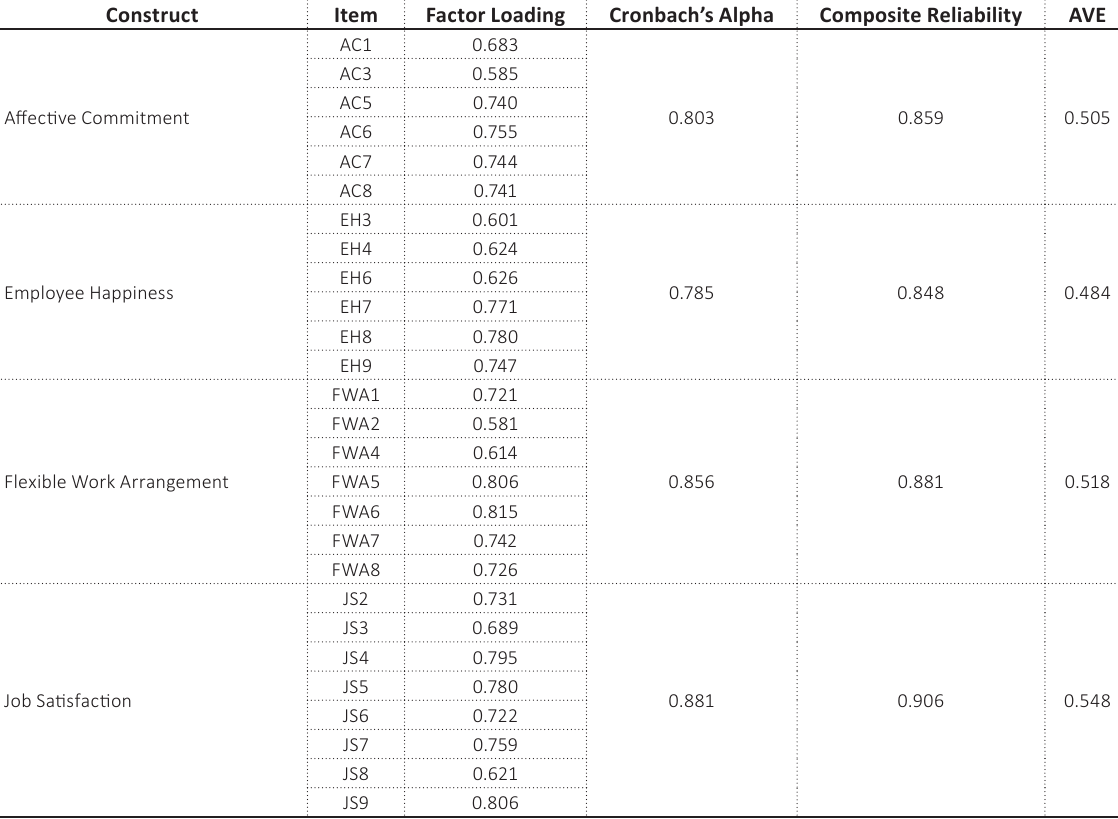
Table 2. Measurement